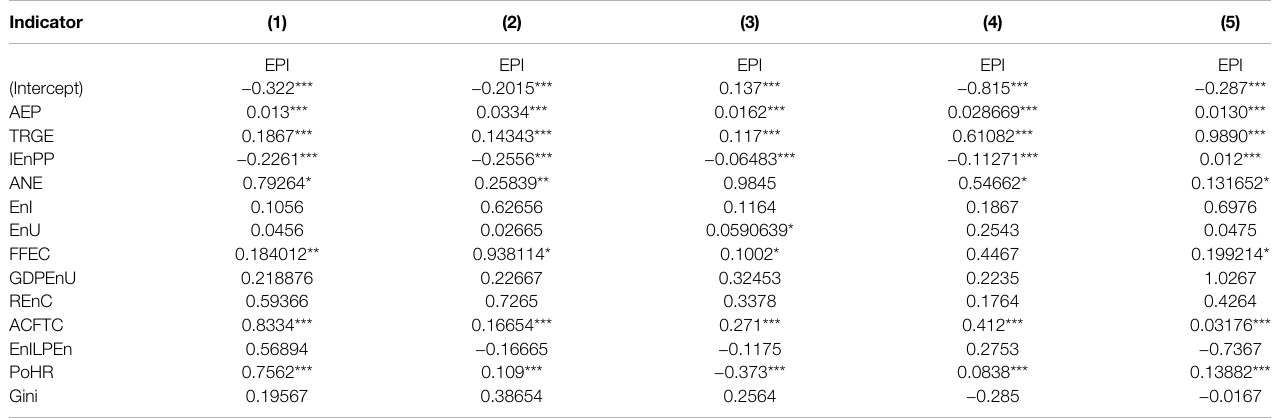
TABLE 2 | Results of the Tobit regression model.